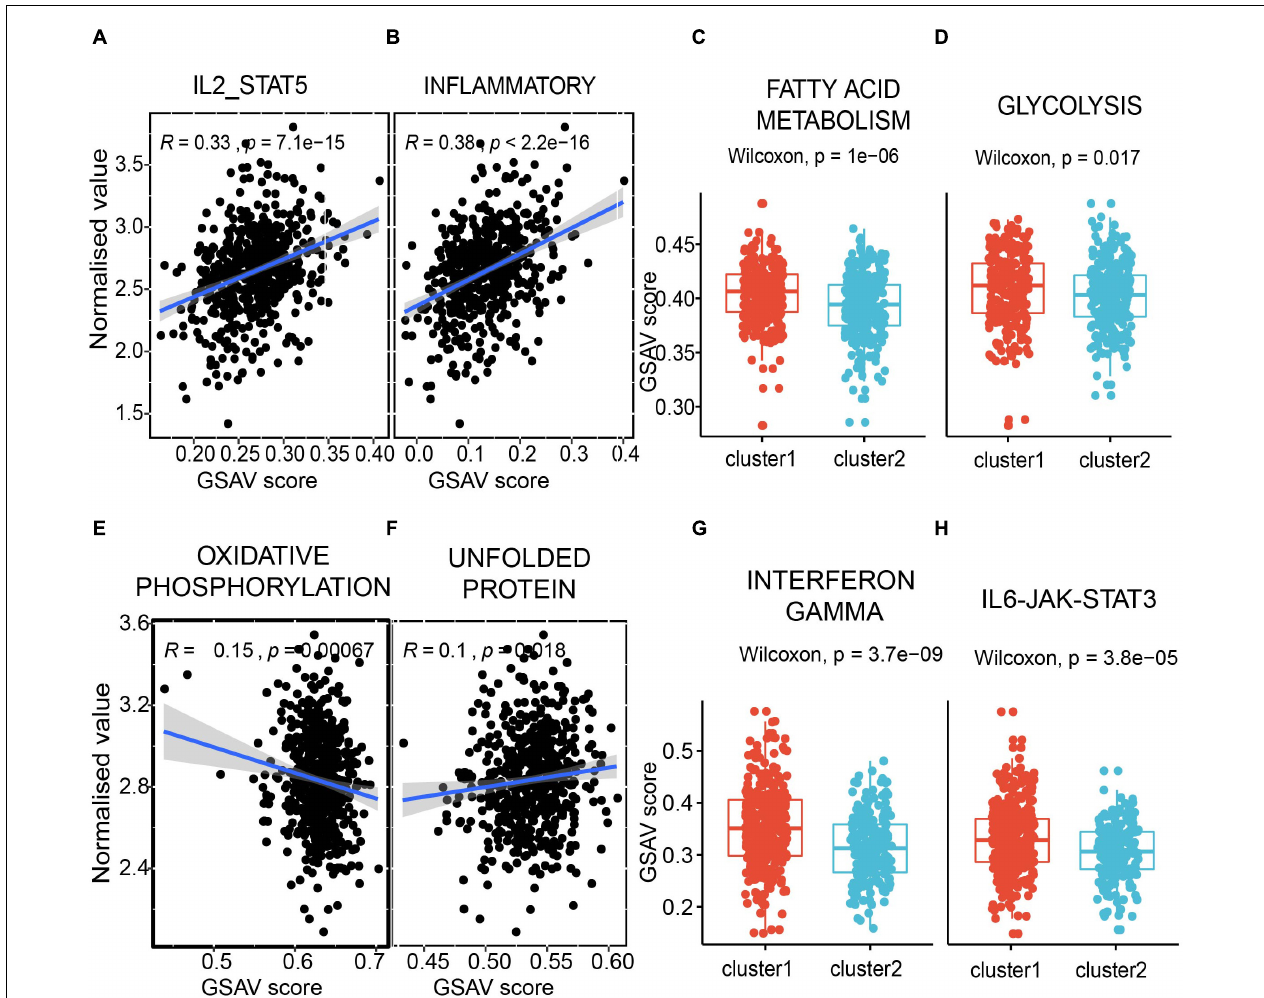
FIGURE 8 | The modules correlated with immunity and metabolism. (A,B) the correlation between the first module and pathway IL2-STAT5 (A) , and inflammatory (B) . Each dot presents a sample. X axis presents the GSVA score, and Y axis presents the normalized expression value. The average expression value of the first module for each sample was used. (C,D) the comparison between two subpopulations from Figure 7C in fatty acid metabolism pathway (C) and glycolysis pathway (D) . Y axis presents the GSVA score. (E,F) the correlation between the second module and pathway oxidative phosphorylation (E) , and unfolded protein (F) . (G,H) the comparison between two sub-populations from Figure 7D in interferon gamma pathway (G) and IL6-JAK-STAT3 pathway (D)